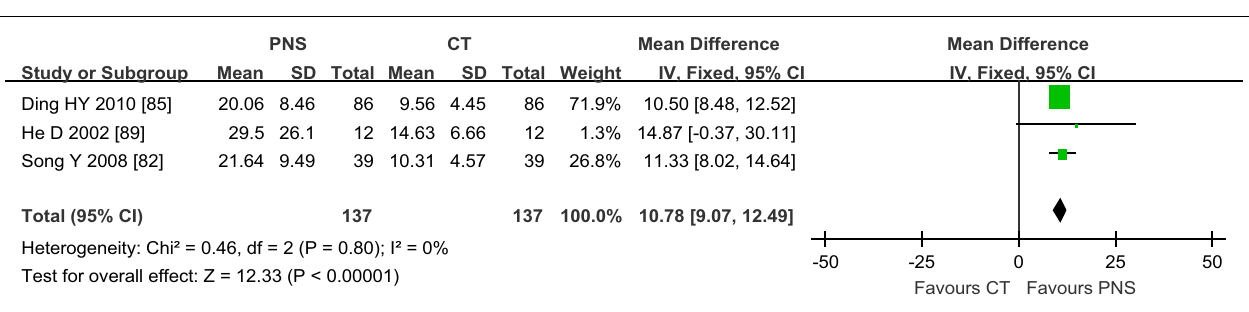
FIGURE 4 | Meta-analyses of intracerebral hematoma volume (IHV) among four subgroups with different time length of PNS treatment: (1) the subtotal group of 6 trials with 4–7days of PNS treatment (Ding HY, He D, Li JM, SongY,TangYH,Yuan K) and, (2) the subgroup of 3 trials with 10–14days of treatment (Chen KZ, SongY,Yuan KZ) showed no significant differences in IHV between PNS and CT